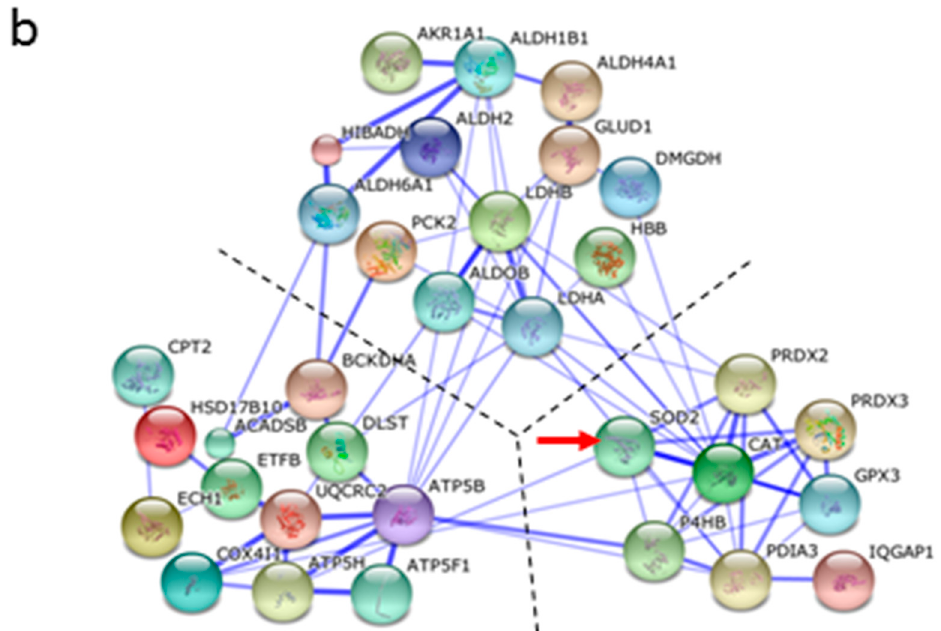
Figure 1. Quantitative proteomic analysis revealed the importance of anti-oxidative stress pathway in ccRCC. ( a ) The heatmap showed the 33 oxidoreductases (by DAVID) were involved in binding cofactor, coenzyme, NAD, NADH or NAD(P). 1: NAD binding site; 2: NAD or NADH binding; 3: nucleotide phosphate-binding region; 4: NAD(P)-binding domain; 5: NAD; 6: coenzyme binding; 7: cofactor binding; 8: oxidation reduction; 9: oxidoreductase. Red arrow showed the candidate protein (MNSOD, SOD2). Green area: gene-term association positively reported, light blue area: gene term association not reported yet; ( b ) visualization of protein–protein interactions of the 37 oxidation-reduction related proteins in ccRCC using STRING analysis (confidence mode). 37 oxidation-reduction related proteins were input into STRING software and they formed three main clusters (only 33 connected proteins were shown and the clusters were divided by dotted lines), among which MNSOD (SOD2, red arrow) were participated in the network and were chosen to be validated later. The solid lines represented interactions between proteins and thickness of the solid lines denoted the confidence level associated with each interactions.